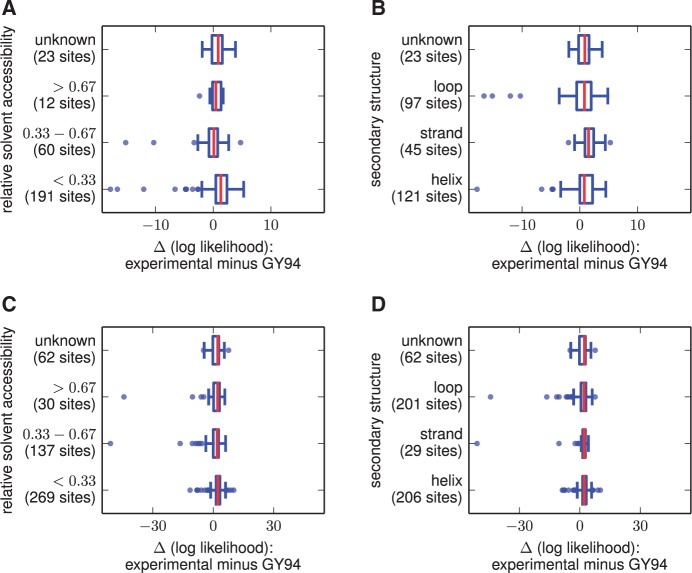
Comparison of
likelihoods on a per-site basis between the best experimentally
informed site-specific evolutionary model and the best
conventional nonsite-specific model. The experimentally informed
models are slightly better (positive Δ(log
likelihood))
for most sites, but far worse for a handful of sites.
(A, B) The best
experimentally informed lactamase model in table 1 versus the
best GY94 variant in table 1. The experimentally informed model has a
higher log likelihood for 72% of lactamase sites.
(C, D) The best
experimentally informed nucleoprotein model in table 7 versus the
best GY94 variant in table 7. The experimentally informed model has a
higher log likelihood for 82% of sites. For both genes,
the per-site likelihoods were computed after fixing the model
parameters and branch lengths to their maximum-likelihood values
for the entire gene. Sites are classified in terms of their
relative solvent accessibility or secondary structure as
computed using DSSP (Kabsch and Sander 1983; Joosten et al. 2011) from PDB
structures 1XPB (Fonzé et al. 1995) or 2IQH (Ye et al. 2006),
normalizing solvent accessibilities to the values provided by
Tien et al.
(2013). The per-residue numerical data are in
supplementary files S3 and S4, Supplementary Material online. The code and data
used to create this figure are provided through http://jbloom.github.io/phyloExpCM/example_2014Analysis_lactamase.html
and http://jbloom.github.io/phyloExpCM/example_2014Analysis_Influenza_NP_Human_1918_Descended_withbeta.html
(last accessed July 28, 2014).